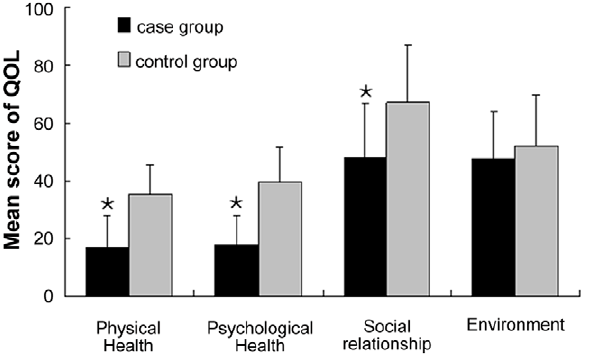
Figure 2. QOL in two groups. The bars represented four domains of QOL as mean score 6 standard deviation. Patients in case group got significantly lower score in the physical health (p , 0.001), psychological health (p , 0.001) and social relationship (p , 0.001). There was no significant difference in score of environment domain between two groups (p=0.203). Abbreviations: QOL = quality of life.